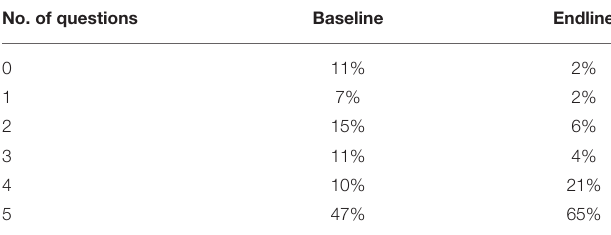
TABLE 6 | Percentage of girls that responded a little/a lot to knowledge questions. No. of questions